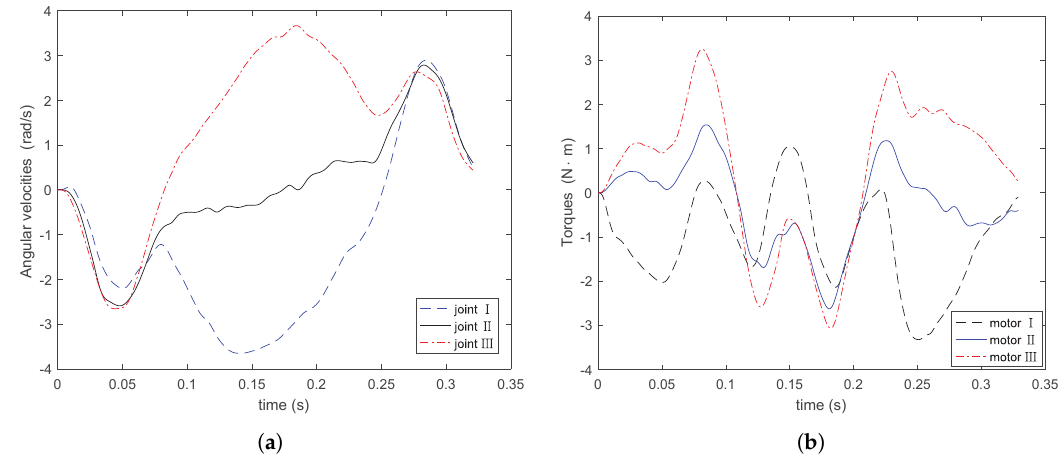
Figure 8. Experimental results of angular velocity and torque by comparison method. ( a ) Angular velocity; ( b )